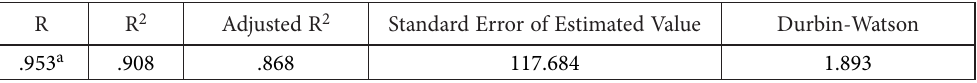
Table 7. Multiple linear regression analysis using the input method – model